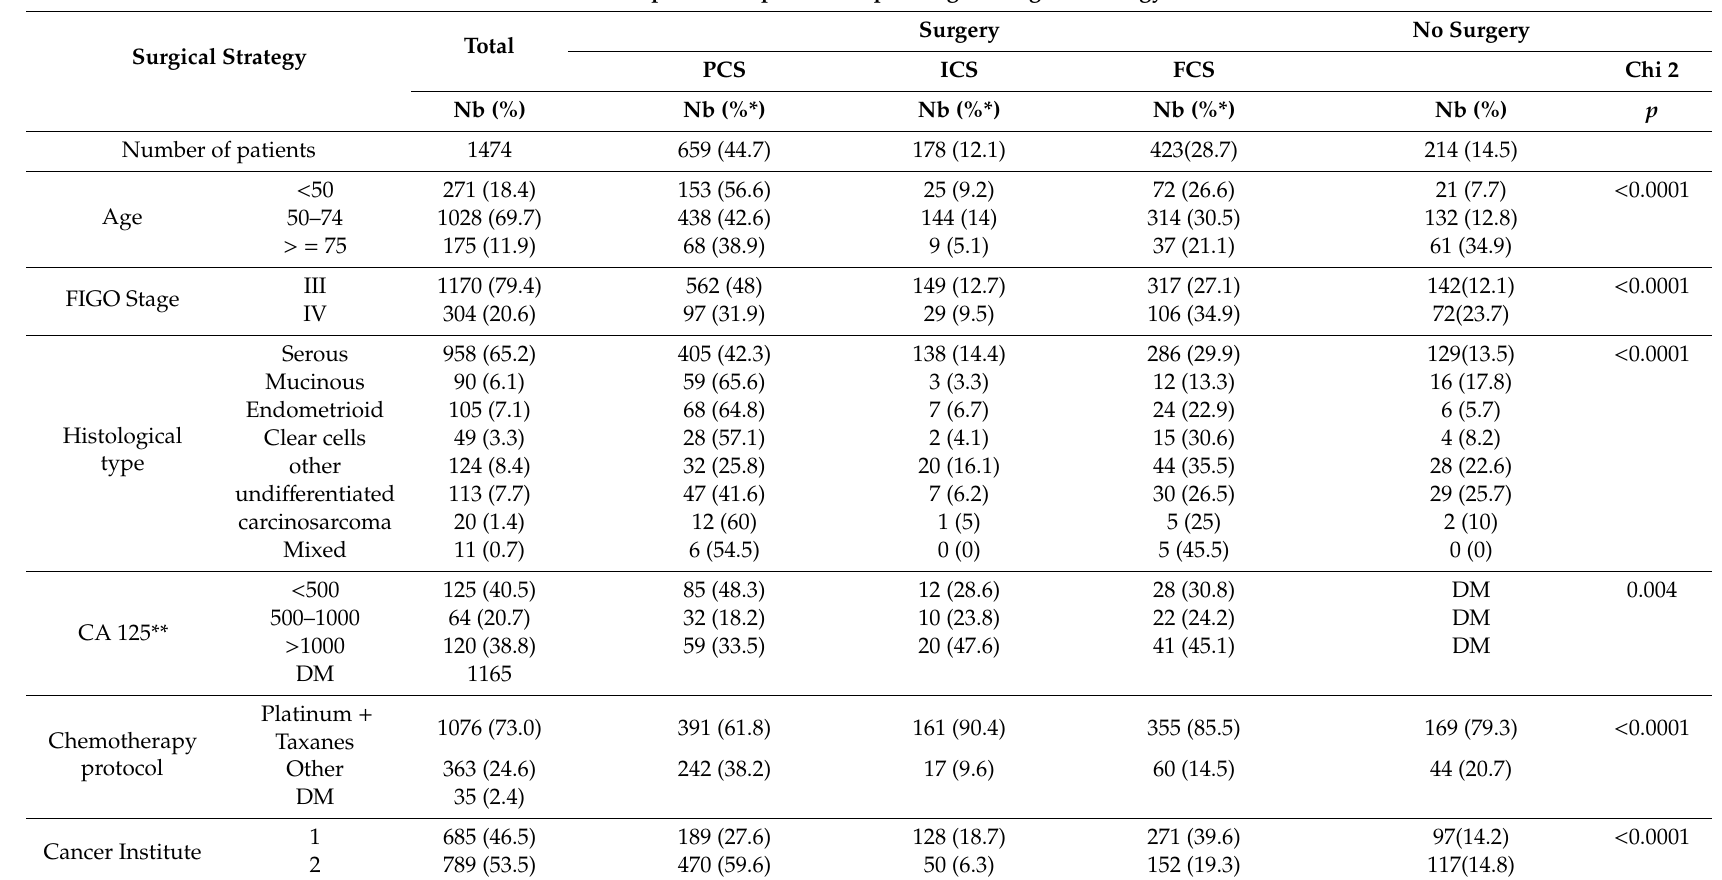
Table 1. Comparison of patients depending on surgical strategy and residual disease. (a) Comparison of patients depending on surgical strategy. (b) Comparison of patients depending on residual disease at the end of surgery. (a) Comparison of patients depending on surgical